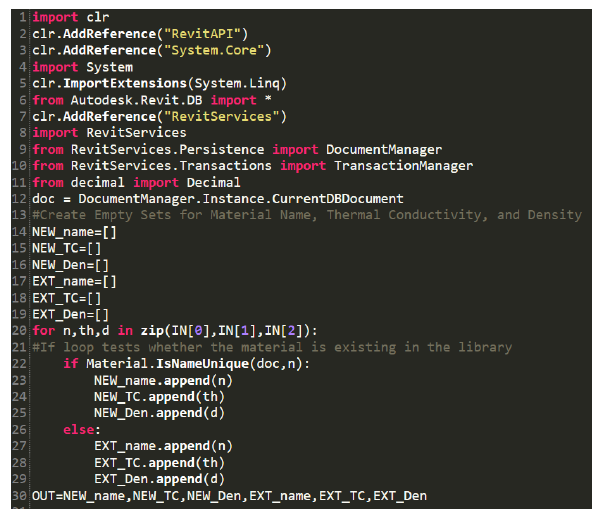
Figure A1. Dynamo Python Script to Test If the Insulation Material is Already in the Revit Material Library. Material Library.